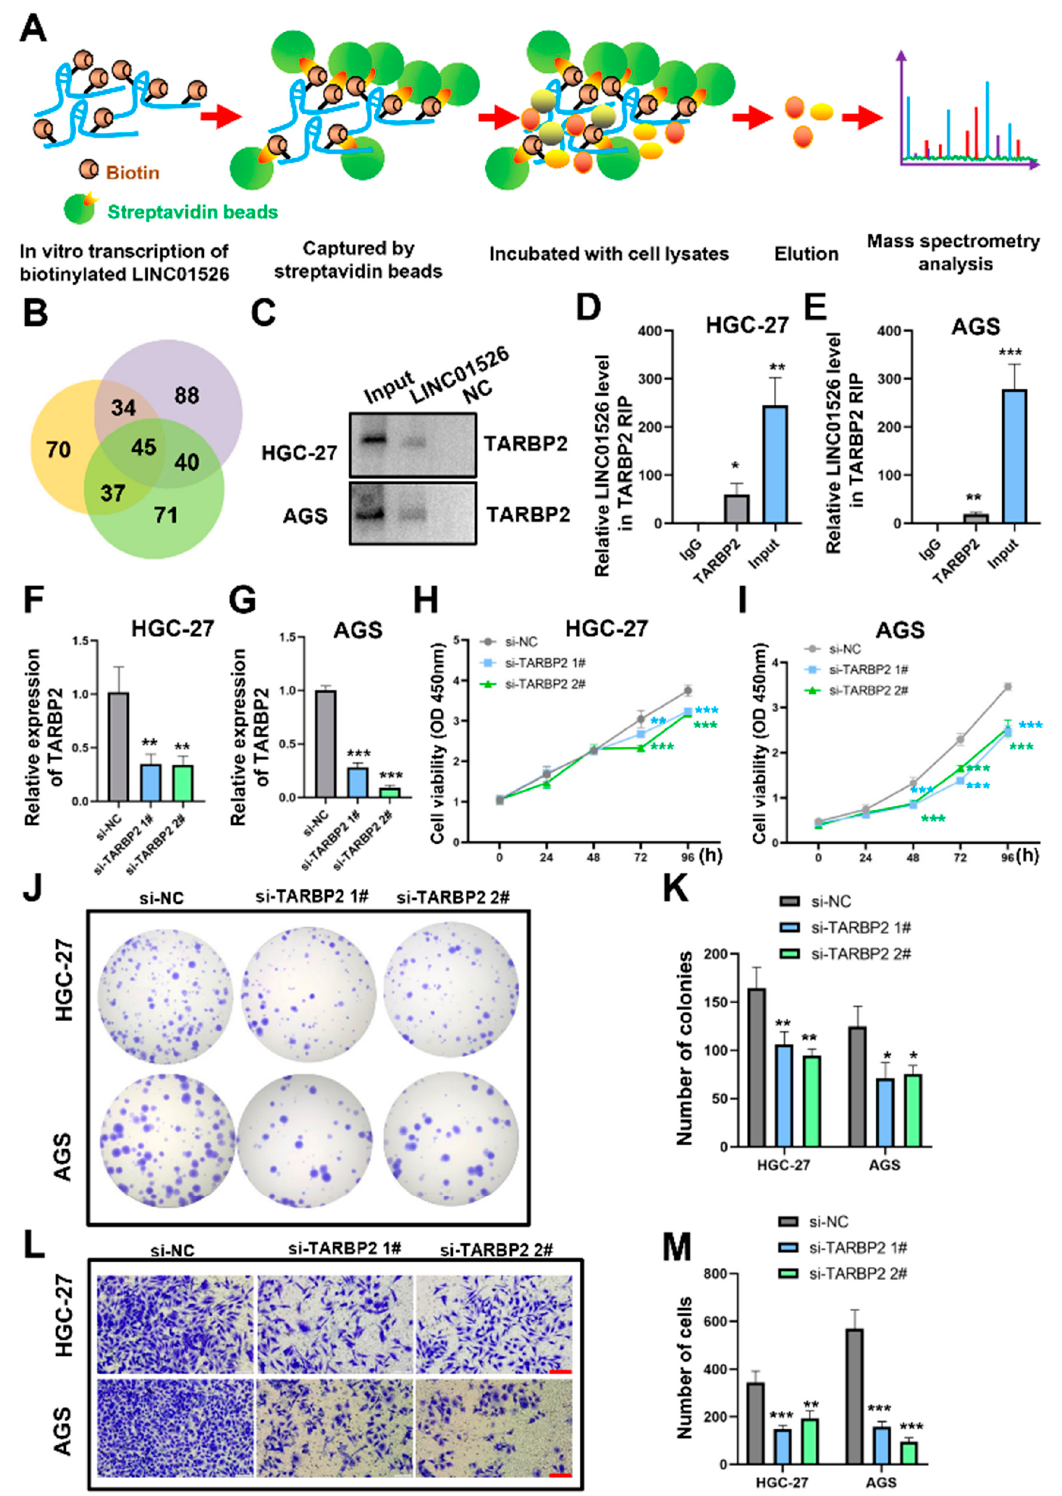
Figure 4. LINC01526 interacts with TARBP2, and TARBP2 acts as an oncogene in GC. ( A ) Flow chart of the RNA pull-down assays. ( B ) Venn diagram of proteins identified by mass spectrometry from three independent RNA pull-down assays. ( C ) Western blot showing the TARBP2 levels after the LINC04526 pull-down assay (n = 3 for each group). The uncropped blots are shown in Figure S2. ( D , E ) Relative LINC01526 levels in TARBP2 RNA immunoprecipitation (RIP) assays in HGC-27 and AGS cells (quantified by RT-qPCR). Rabbit IgG was the negative control for immunoprecipitation (n = 3 in each group). ( F , G ) Relative TARBP2 expression levels in HGC-27 and AGS cells transfected